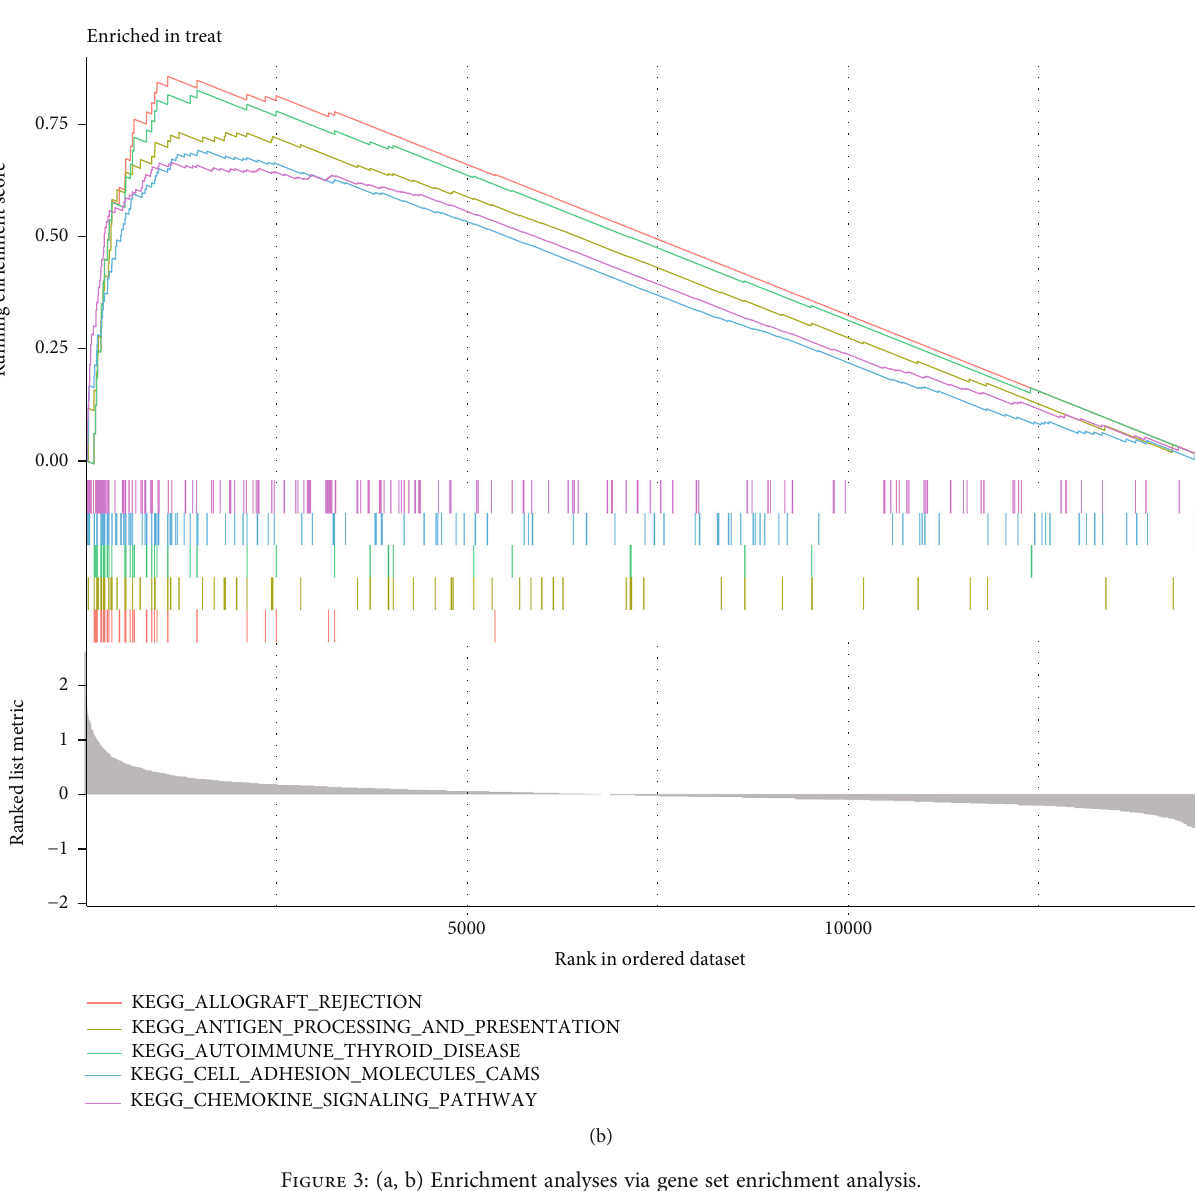
Figure 3: (a, b) Enrichment analyses via gene set enrichment